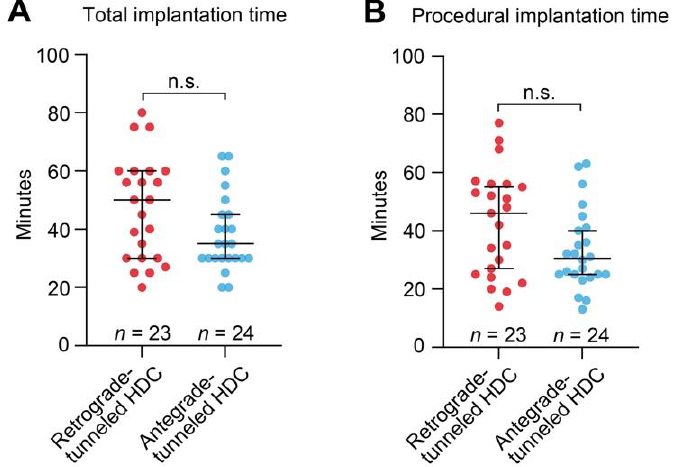
Figure 2. ( A , B ) Comparison of HDC implantation time in retrograde- and antegrade-tunneled HDCs. For group comparisons, the Mann–Whitney U-test was used to determine differences in medians. Abbreviations: HDC, hemodialysis catheter; n.s., not significant.